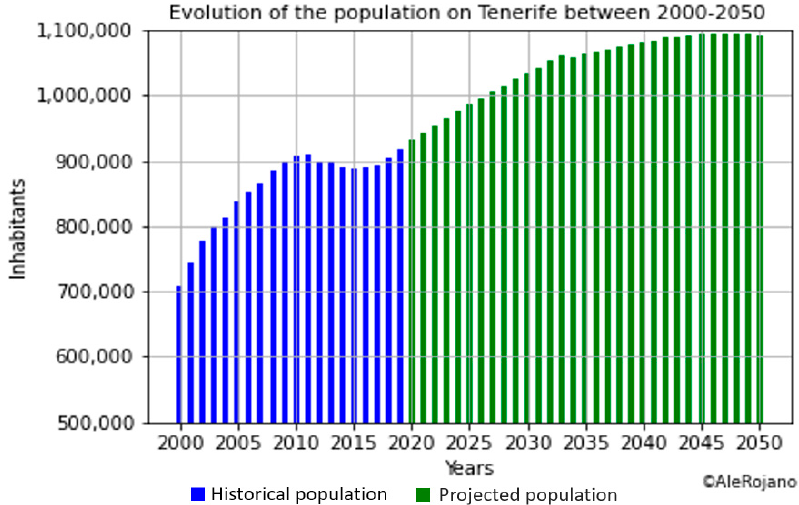
Figure 4. Evolution and projections of the population on the island of Tenerife between 2000–2050.